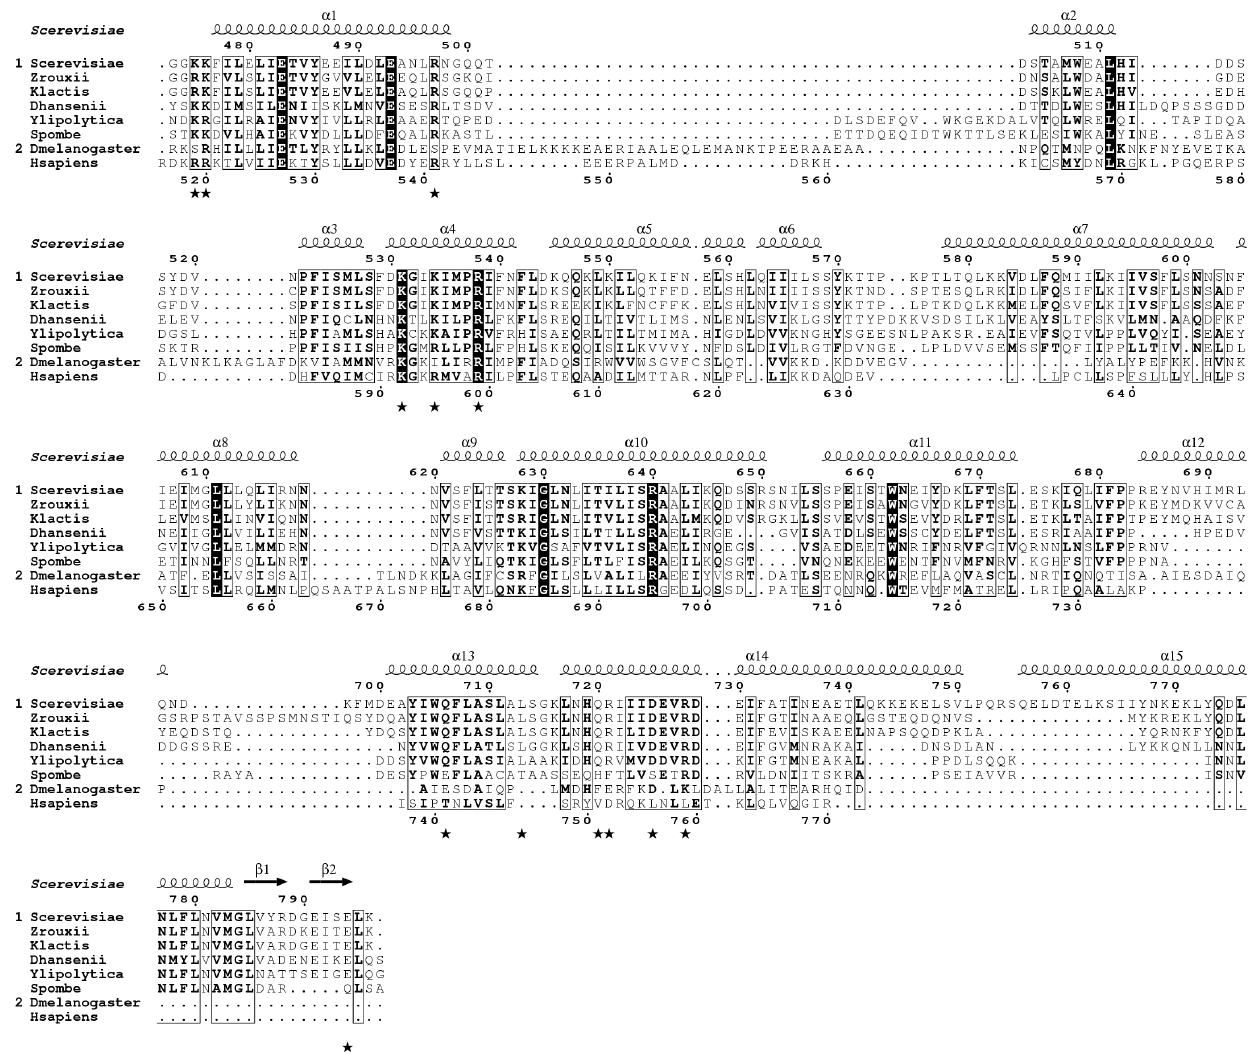
Figure 2. Sequence alignment of Pat1 orthologues. Alignment was performed using ClustalW [69]. Strictly conserved residues are in white on a black background. Partially conserved amino acids are boxed. Secondary structure elements assigned from the ScPat1C structure are indicated above the alignment. Black stars below the sequences indicate residues mutated in this study. This figure was generated using the ESPript server [70].